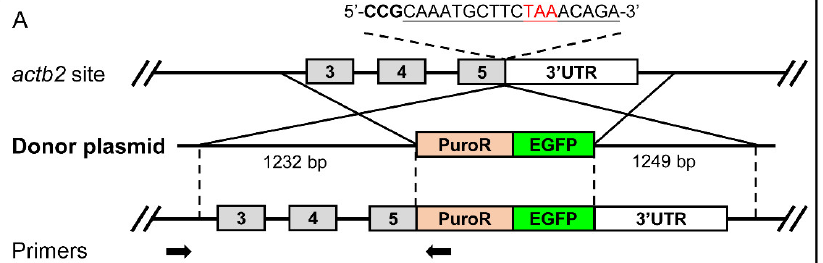
Figure 6. pCas9-mU6sgRNA efficiently mediated the reporter gene puroR-EGFP knock-in in medaka cultured cells and embryos. ( A ) Schematic diagram of gene targeting strategy at medaka actb2 . The donor plasmid containing a promoter-less puroR-EGFP gene was constructed for tar-